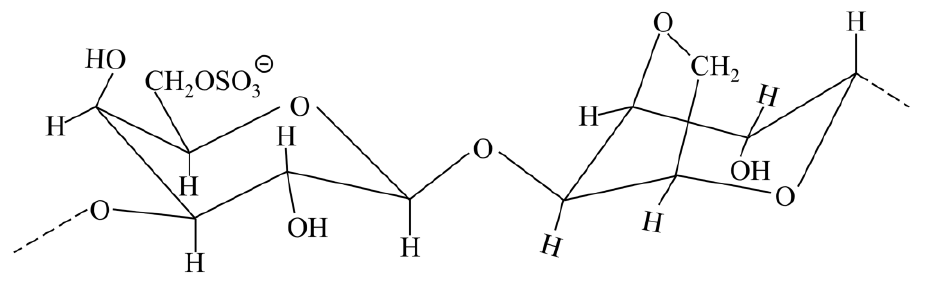
Figure 1. The main polar structural formula of funoran.